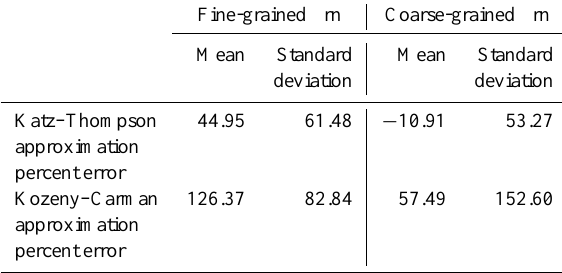
Table 1. Summary statistics of the percentage errors of the Katz– Thompson and Kozeny–Carman